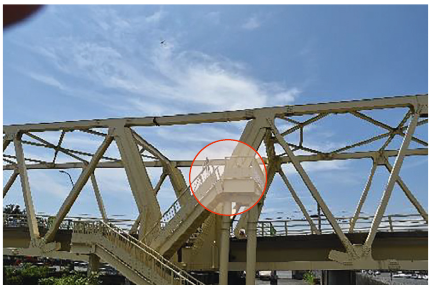
Figure 6: Damage and detachment of the bridge and sidewalk stairs of Yokoe